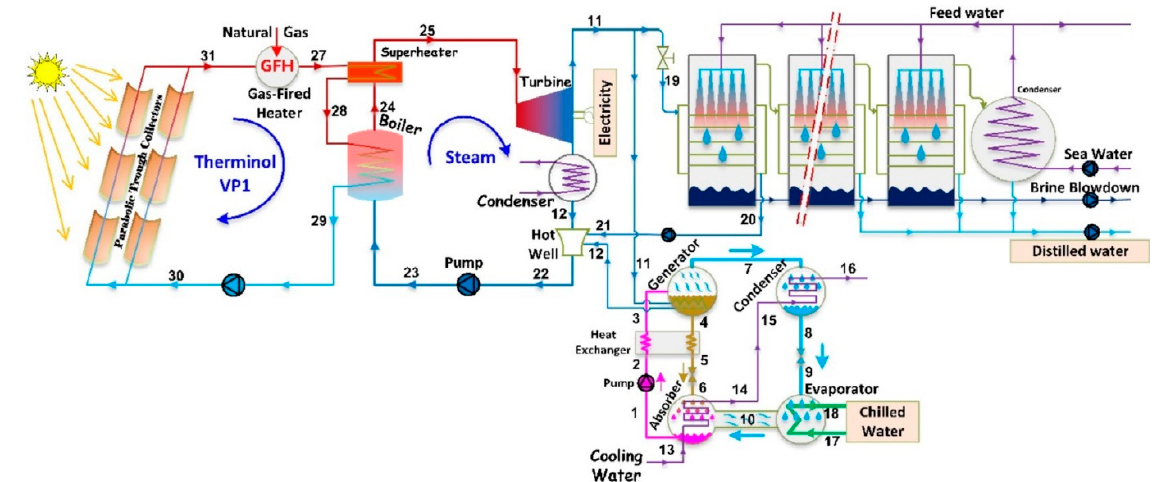
Figure 9. Schematic diagram of the integrated polygeneration plant proposed by Abdelhay et al. [80]. The plant is composed of a solar power system (SPS), multi-effect distillation (MED), and an absorption refrigeration system (ARS).